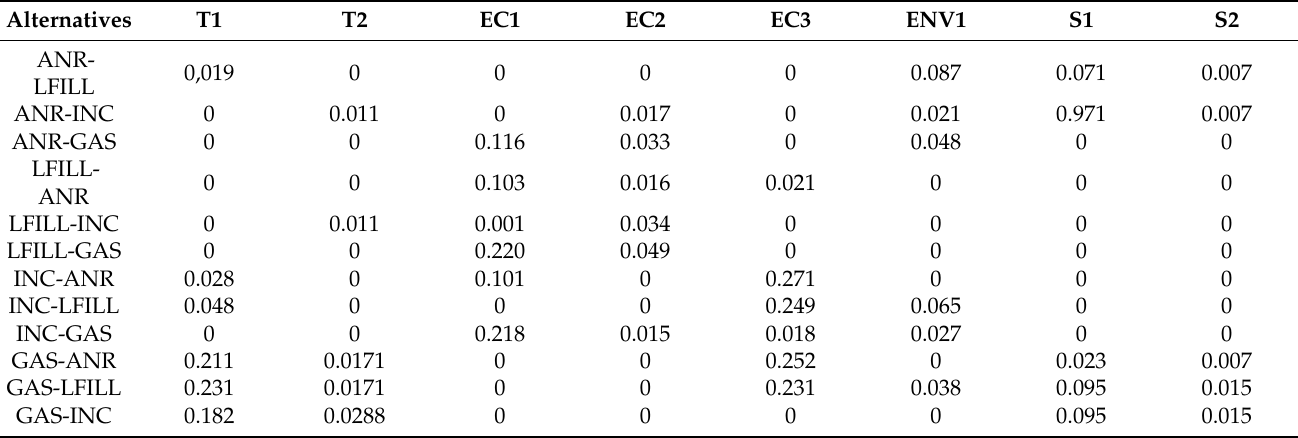
Table 8. Aggregate preference